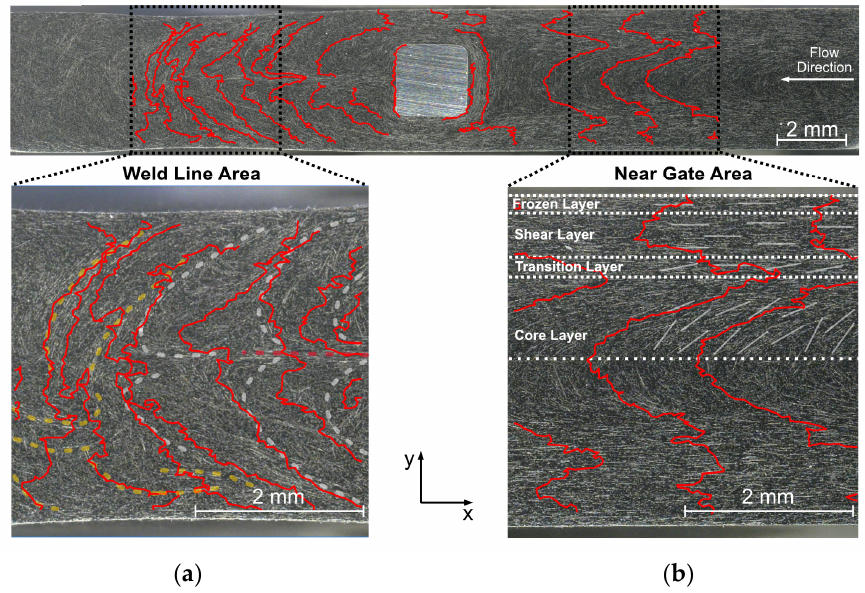
Figure 12. Transfer of the equipotential lines to the microscopy image with equipotential lines (red) and schematically marked characteristic fiber orientations (yellow, white) with focus on near gate area ( b ) and weld line area ( a ).